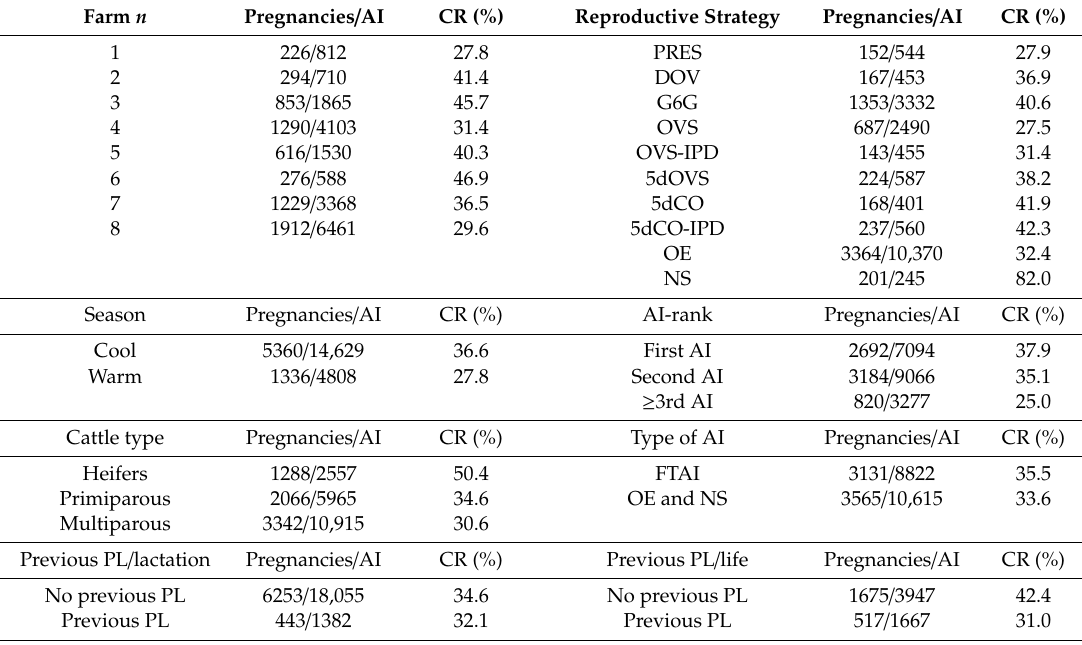
Table 3. Conception rate (CR) descriptive statistics for farm, reproductive strategy, season, AI-rank, cattle type, type of AI, and previous pregnancy loss across eight Spanish Holstein